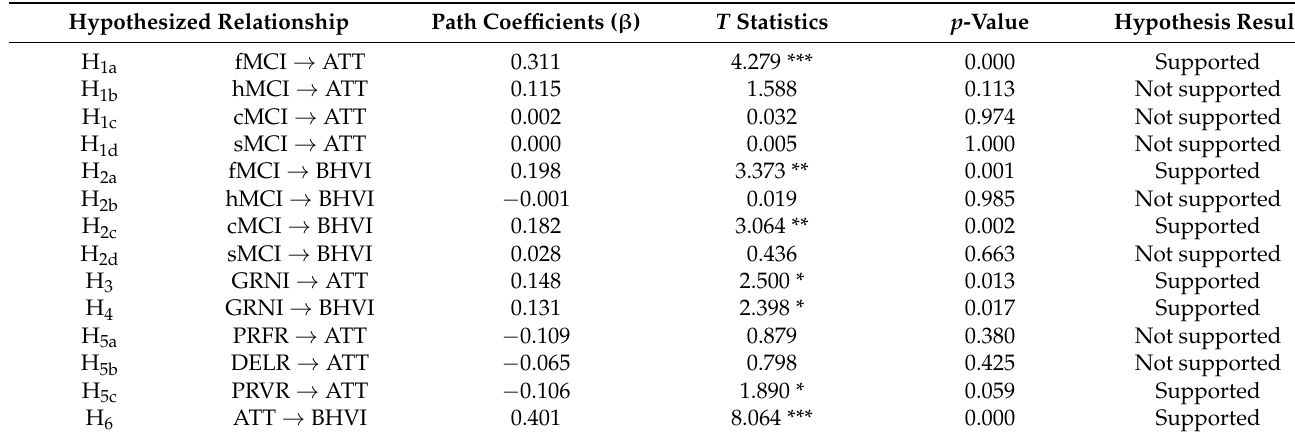
Table 7. Hypotheses testing.